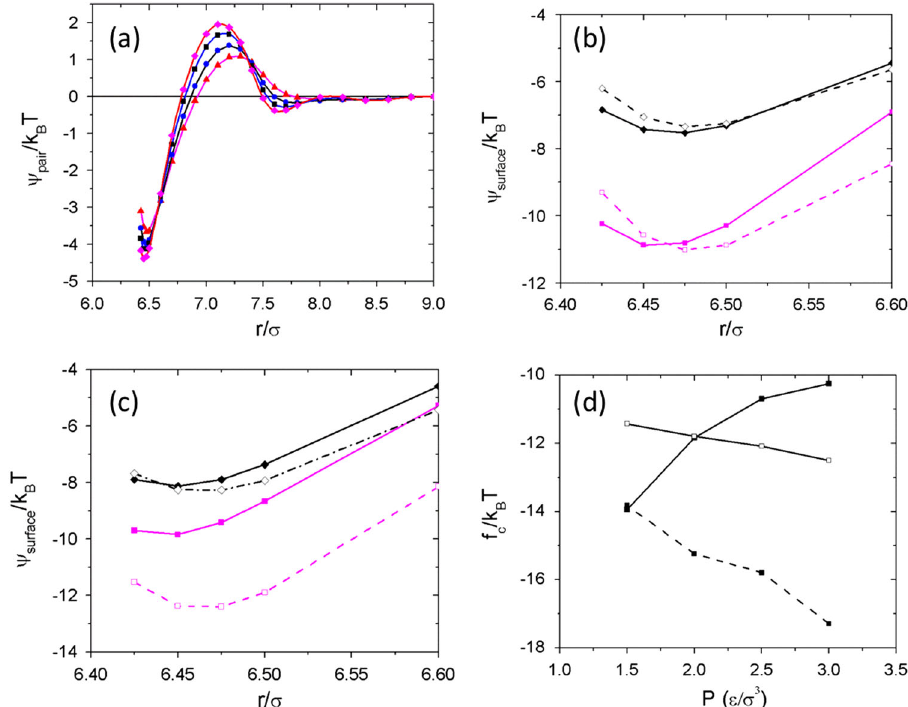
Fig. 5 a Two-body potential of mean force Ψ pair measured from simulations with chain length M = 10, and P = 0.15 ε / σ 3 ( red ), 0.20 ε / σ 3 ( blue ), 0.25 ε / σ 3 ( black ) and 0.30 ε / σ 3 ( magenta ). b “ Surface ” potential of mean force Ψ surface with chain length M = 10 at P = 1.5 ε / σ 3 . The fi lled symbols are results directly measured from simulations, and the open symbols are values calculated from Ψ pair using the pair-additive assumption. The Ψ c Same as b , but at P = 2.5 ε / σ 3 . d The free energy per colloid as a function of ϕ Ψ tri and HCP are shown in black and magenta , respectively. the HCP colloidal crystal ( fi lled symbol and solid line ), the “ open ” colloidal structure ( open symbol and solid line ), and the hypothetical HCP colloidal crystal in absence of many-body effects ( fi lled symbol dotted line